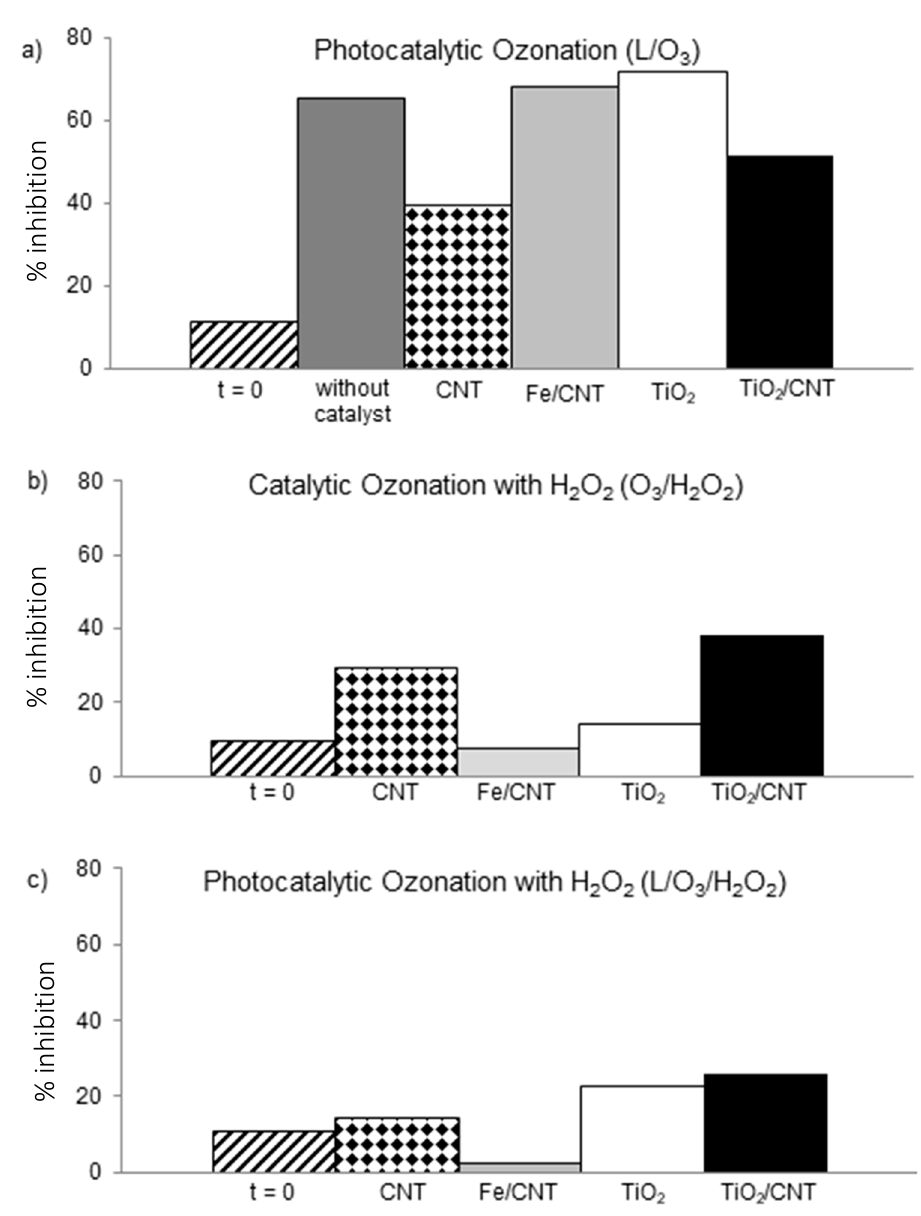
Figure 8. Light emission inhibition of Vibrio fischeri bacteria when submitted to samples resulting from the treatment (after 180 min) of SMX by photocatalytic ozonation ( a ), catalytic ozonation with H 2 O 2 ( b ), and photocatalytic ozonation with H 2 O 2 ( c ).